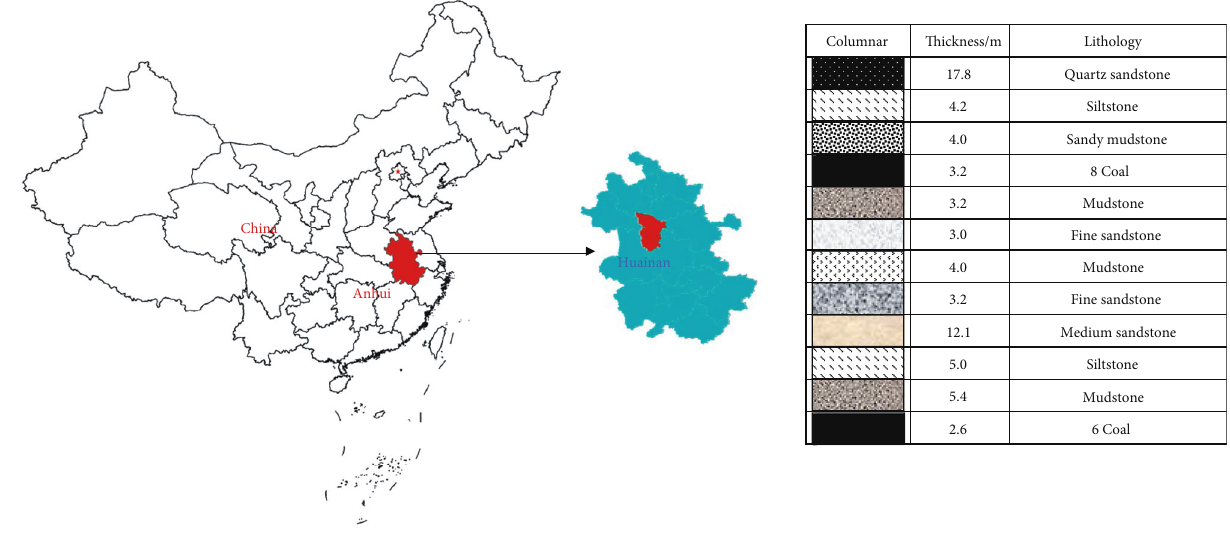
Figure 1: Layout plan of fully mechanized 11318E coal mining face and